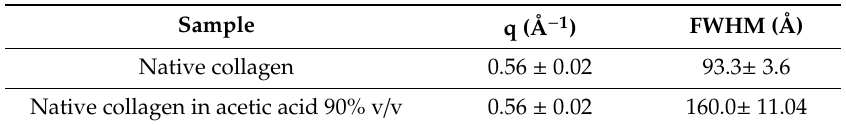
Table 4. Full-Width-at Half-Maximum (FWHM) of 1D azimuthal intensity profiles of the equatorial di ff raction peak (q = 0.56 Å − 1 ) for both native and acidic